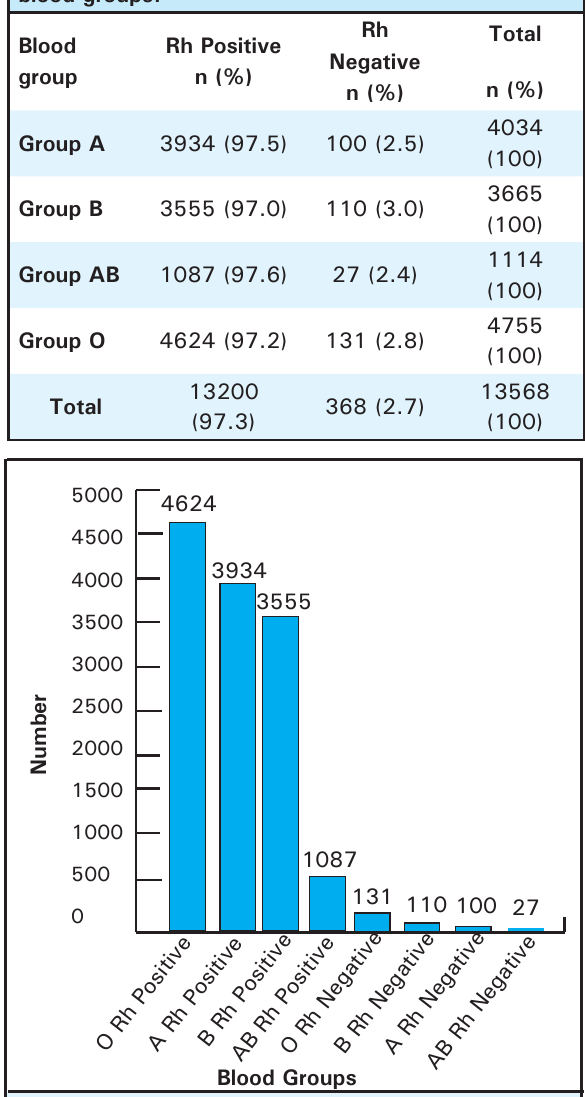
Figure 3. Frequencies of blood groups in decreasing order. The most common blood group was O positive 4624 (34.1%) while, AB negative 27 (0.2%) blood group is the rarest one (Figure 3).